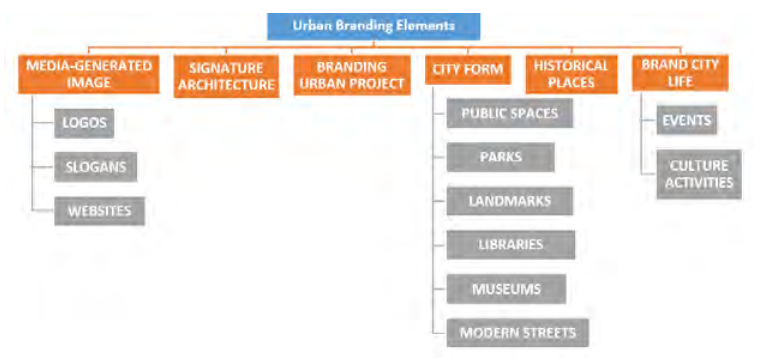
Figure 4. Urban Branding Elements